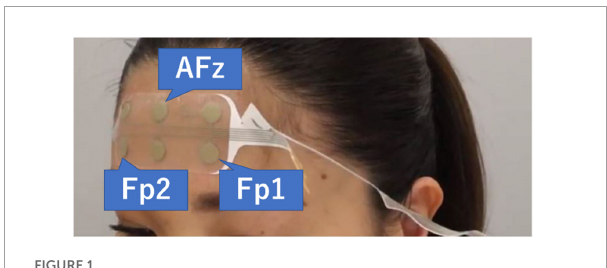
FIGURE1 The electrode sheet is attached. The three channels used are AFz, Fp1, and Fp2. The reference electrode was positioned at the left mastoid. PGV Inc. (n.d.b).